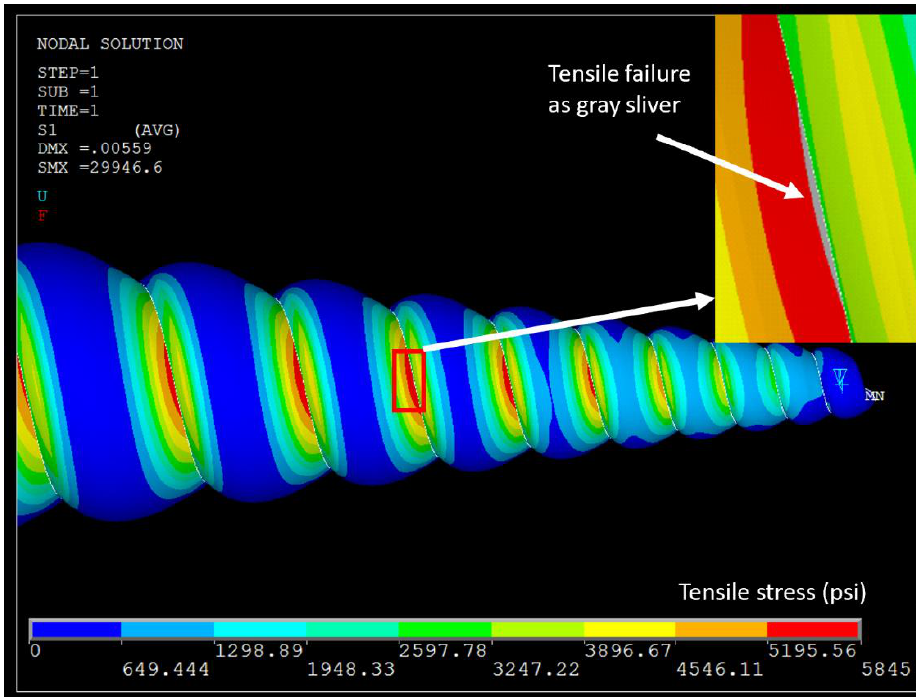
Figure 9. Tensile failure occurs at a suture on the bottom surface of the shell. The color scale ranges from 0 psi to 5845 psi, the tensile strength of calcium carbonate. The gray sliver in the cutout indicates that the tensile capacity is exceeded and the location of the failure.